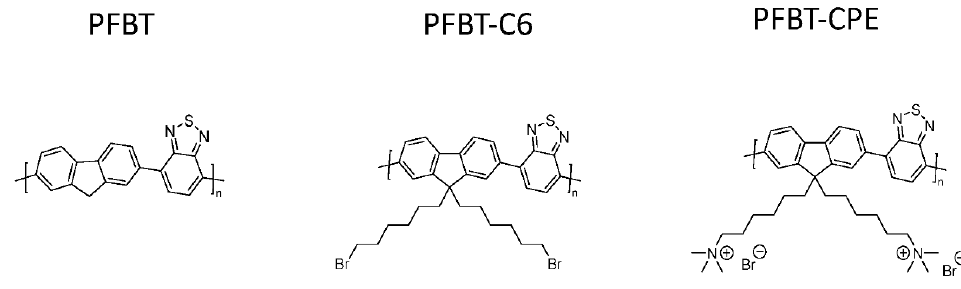
Figure 18. Structure of PFBT , precursor PFBT-C6 and the polyelectrolytes PFBT-CPE [109].